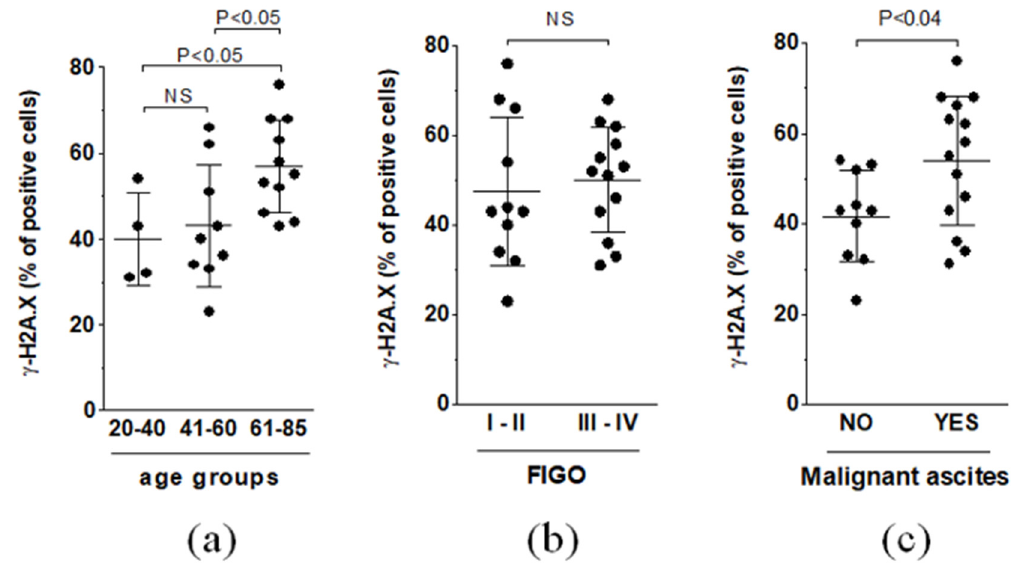
Figure 4. The comparison of the average areas representing the expression of γ -H2A.X with respect to patient age ( a ), FIGO stage ( b ), and malignant ascites status ( c ). Experiments were performed on 24 separate ovarian tumors obtained from different patients. The results are expressed as the means ± SDs.